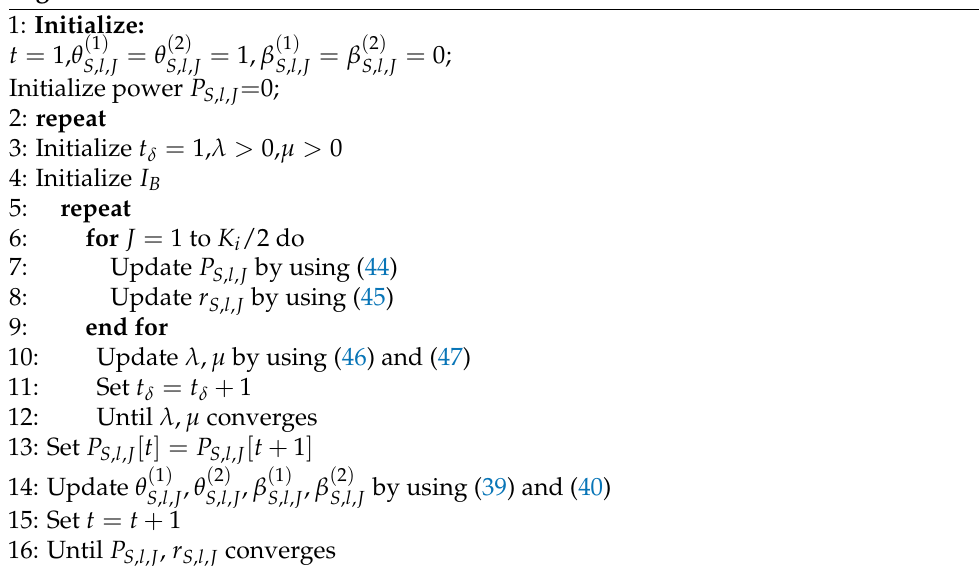
Algorithm 1 Satellite Beam Channel Resource